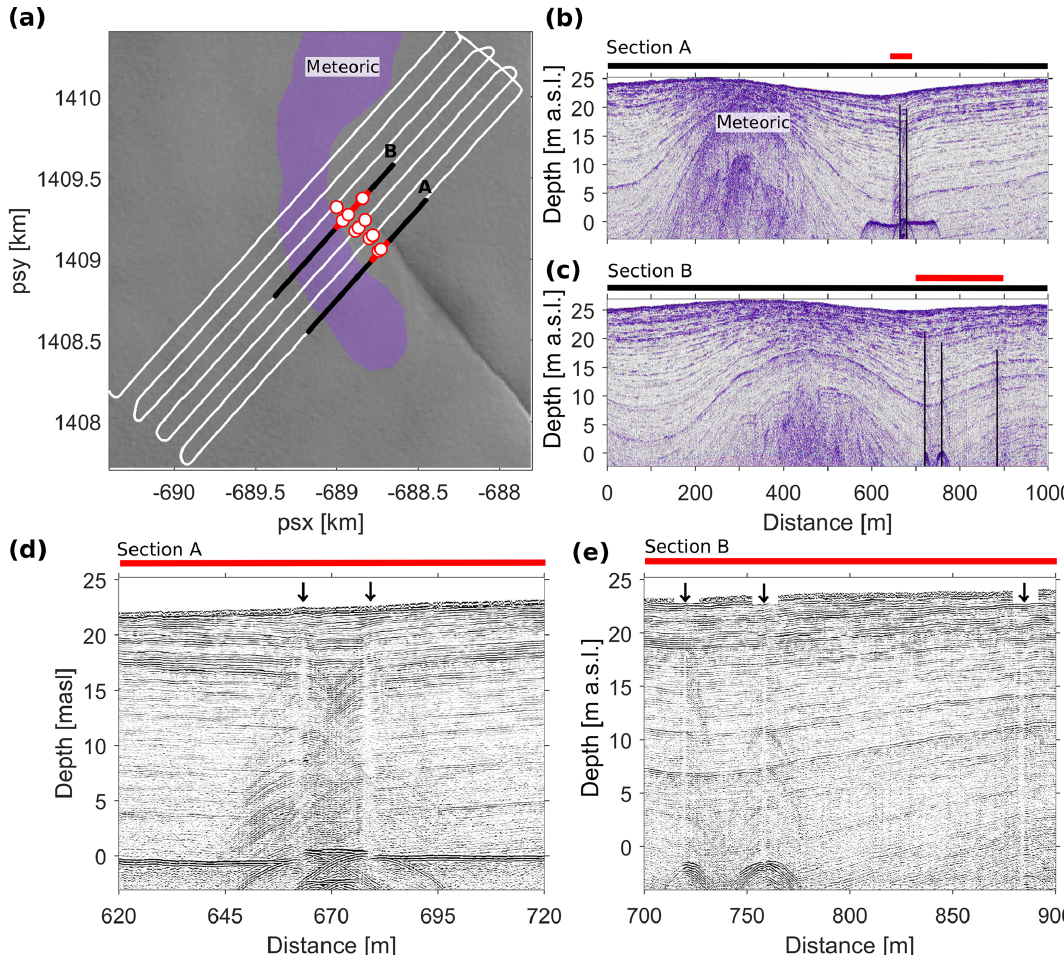
Figure 3. (a) GPS track of a GPR survey carried out on 4 May 2016 (white line), overlying a Landsat 8 image from 3 March 2016. Red dots correspond to locations where a fracture has been observed in the GPR data. Black line segments A and B correspond to the location of the radar sections displayed in panels (b) and (c) , respectively. The purple shading outlines the location of a large structure of meteoric ice embedded within the ice shelf (b) Radar section along line segment A in panel (a) . Vertical black lines indicate the location of fractures in the ice shelf. (c) Similar to panel (b) but for line segment B. (d) A detailed view of the fractures along section A. The spatial extent is indicated by the red line above panel (b) and vertical arrows locate the radar signature of each fracture. (e) Similar to panel (d) but for section B.